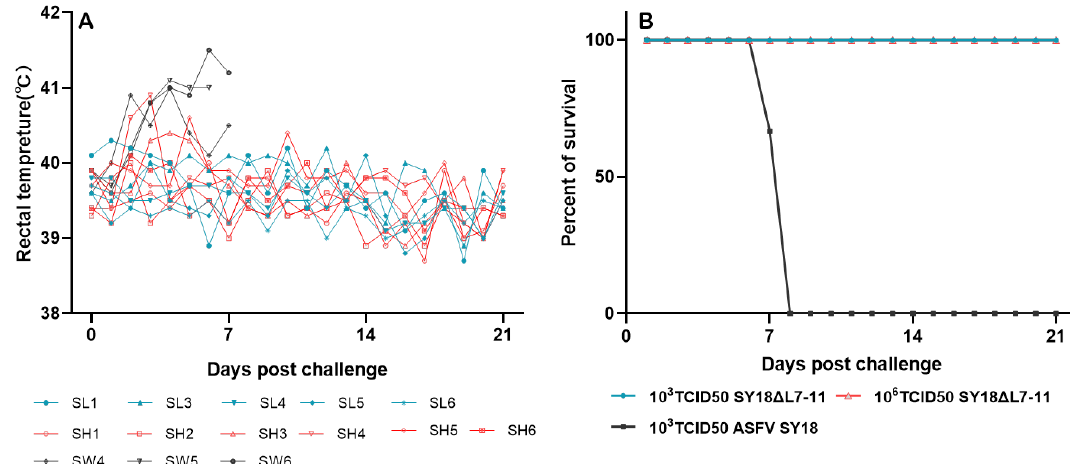
Figure 4. Fever response ( A ) and survival ( B ) of swine after challenge with ASFV SY18. Pigs SL1-SL6 and pigs SH1-SH6 were inoculated with 10 3 TCID 50 or 10 6 TCID 50 SY18 (cid:52) L7-11 before challenge. Each curve in figure A represents data